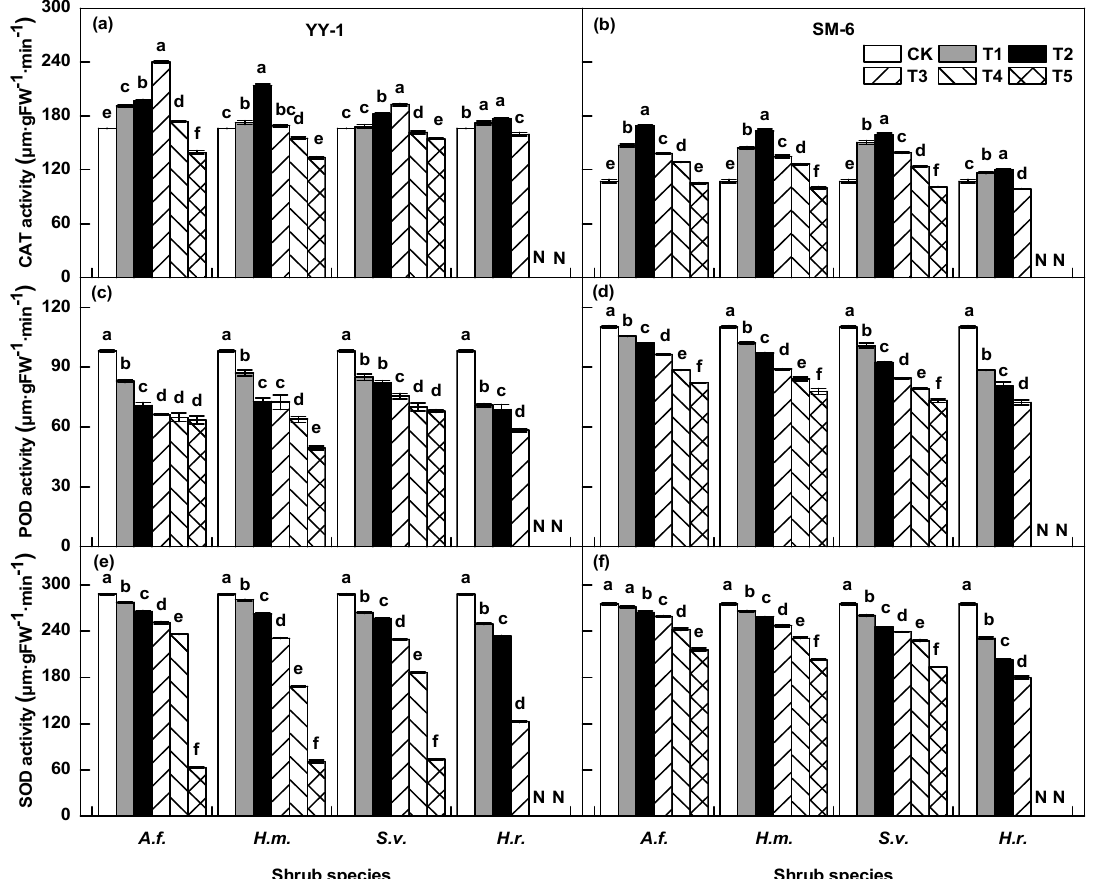
Figure 3. Effect of different concentrations of four shrub species’ aqueous leaf extracts on enzyme activity of A. pedunculata . ( a – f ). Data (Mean ± Standard Error, n = 42) of the activity of catalase (CAT) ( a , b ), peroxidase (POD) ( c , d ), and superoxide dismutase (SOD) ( e , f ) of the target A. pedunculata species of YY-1 and SM-6 seedlings exposed to six concentrations 0 (CK), 0.025 (T1), 0.05 (T2), 0.1 (T3), 0.15 (T4), and 0.2 g · mL − 1 (T5) of aqueous leaf extracts from the donor species— Amorpha fruticosa ( A.f. ), Hedysarum mongolicum ( H.m. ), Sabina vulgaris ( S.v. ), and Hippophae rhamnoides ( H.r. ). N means no value (all the plants death and no relevant indicators have been detected). Different little letters indicate significant difference ( p < 0.05). Vertical bars represent standard errors ( n =